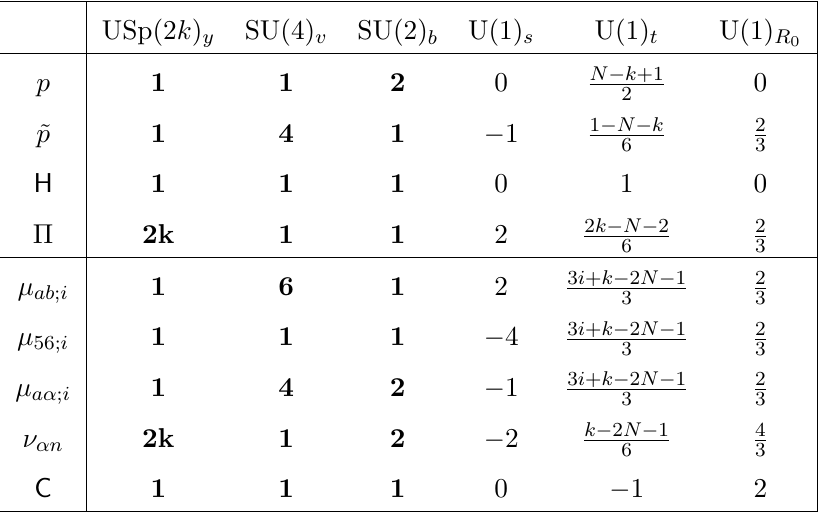
Table 9 . Transformation properties under the global symmetry of the matter fields of Theory B. We are also including some important operators of the E [USp(2 k )] block. The horizontal line separates operators charged under the USp(2 k ) gauge symmetry from the